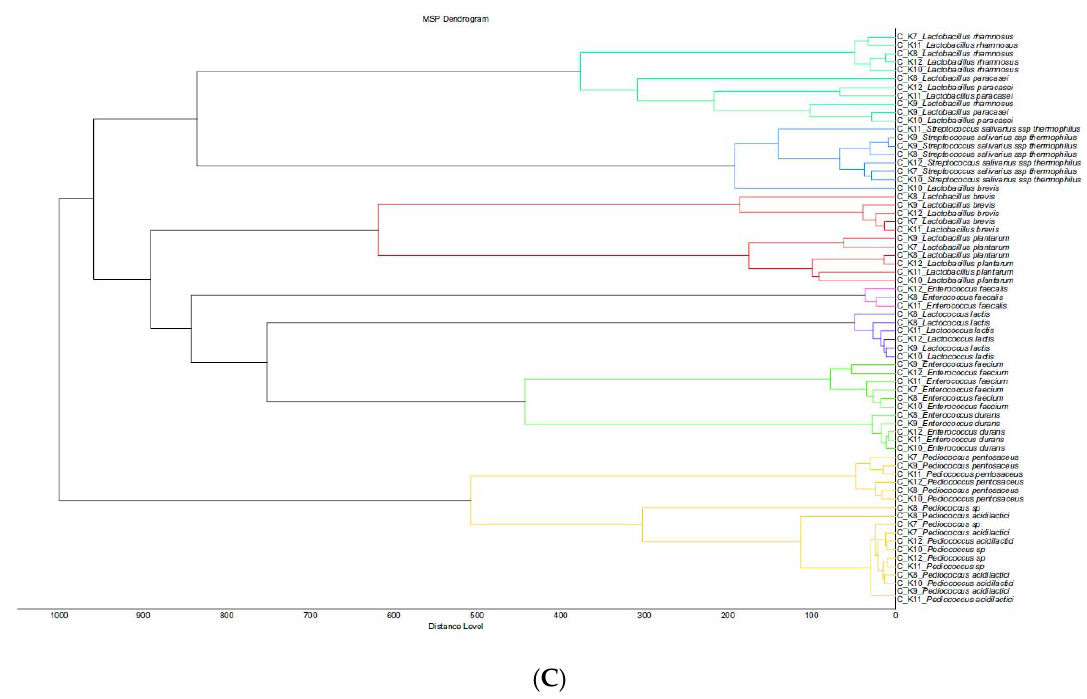
Figure 1. ( A – C ) Phylloproteomic trees (dendrograms) of the investigated bacterial species based on the MSP identification via the MALDI Biotyper platform for the three groups A, B and C. The dendrogram’s scale on the bottom represents the relative distance used in the clustering analysis.